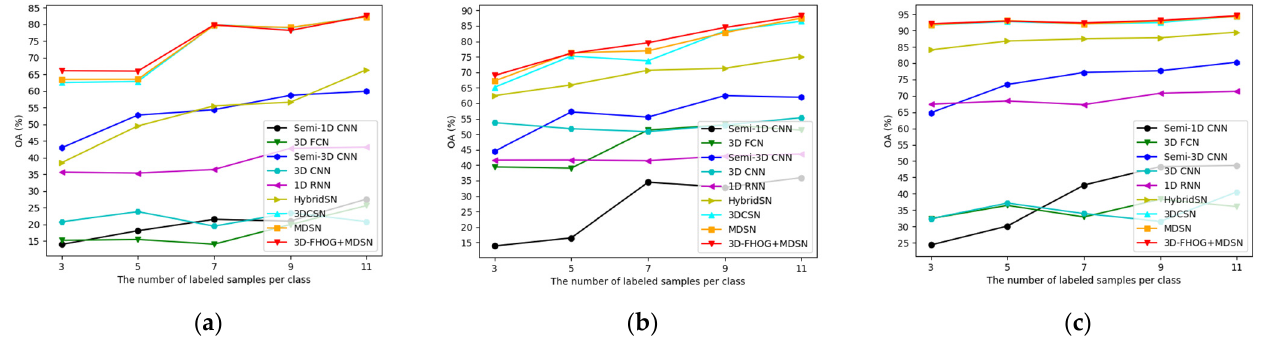
Figure 10. OA as functions of the number of labeled samples per class on three test data sets: ( a ) IP data set; ( b ) PU data set; ( c ) SA data set.